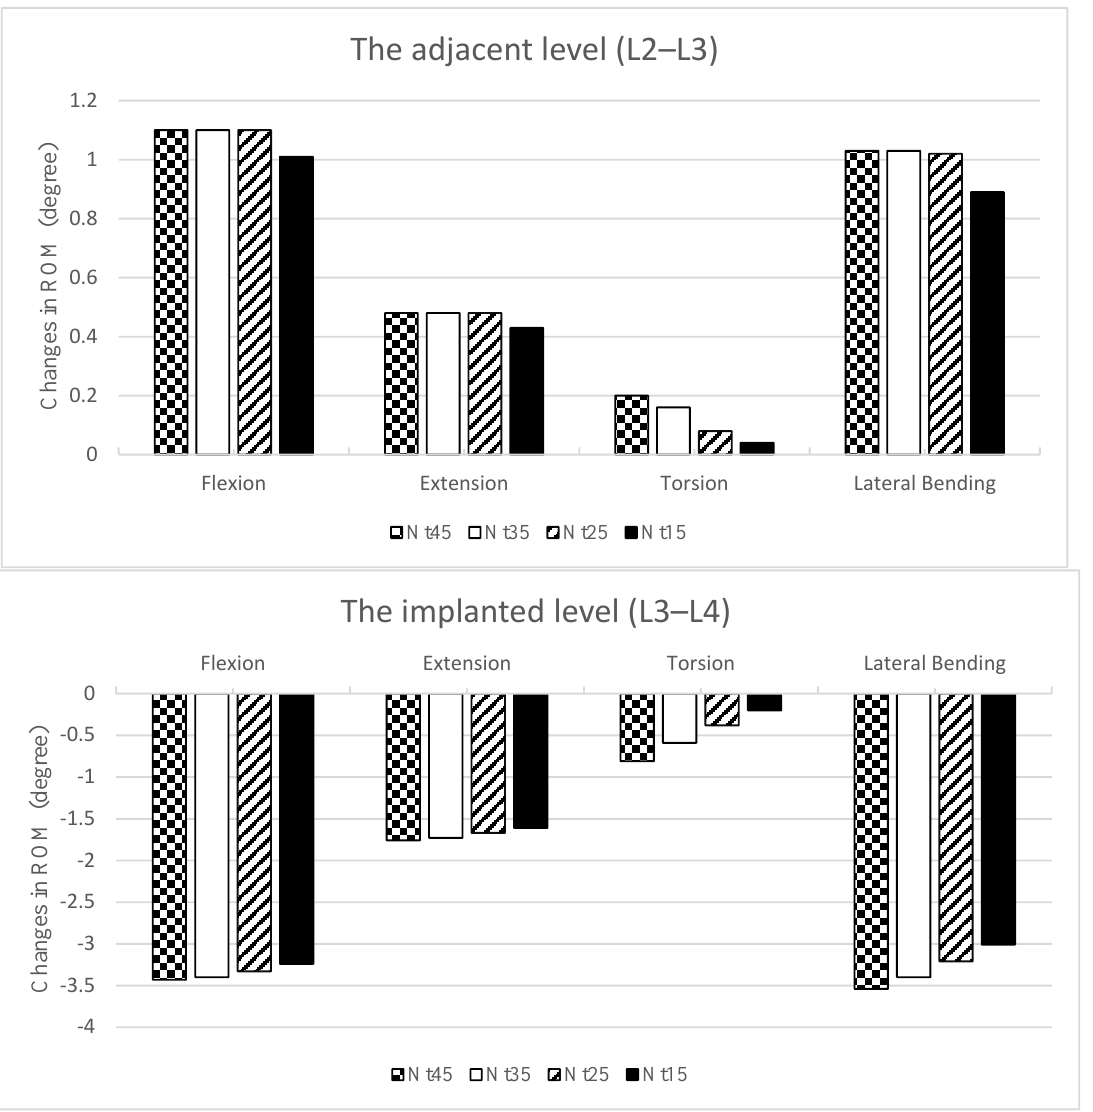
Figure 2. Changes in the ROM normalized and compared with the INT at the adjacent L2 – L3 level ( top ) and the implanted L3 – L4 level ( bottom ). The ROMs were all increased at L2 – L3 and all decreased at L3 – L4. There was a downward trend in ROM changes at all levels as the NS diameter became smaller.